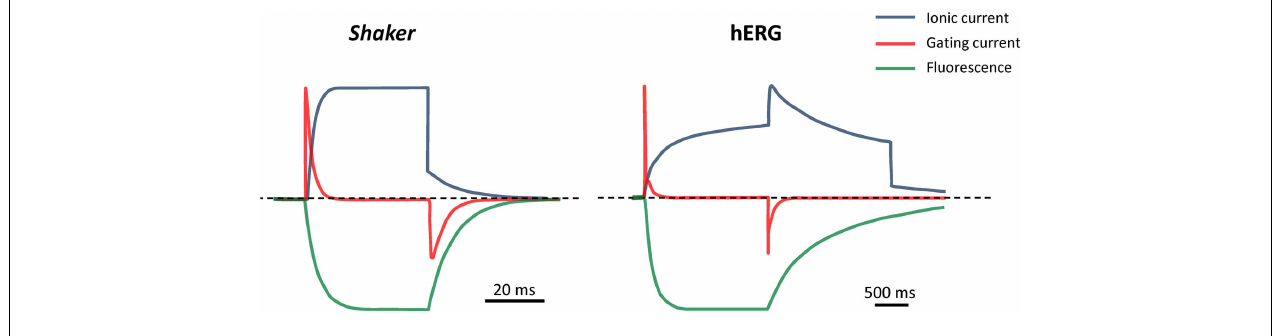
fluorophores attached at the outer end of S4, to Shaker A359C or hERG L520C. Note the different timescales and step durations for the fast-activating Shaker and slow-activating hERG channels. Schematics were generated based on data from primary sources cited in the text (see Does Slow S4 Voltage Sensor Movement Underlie Slow hERG Gating